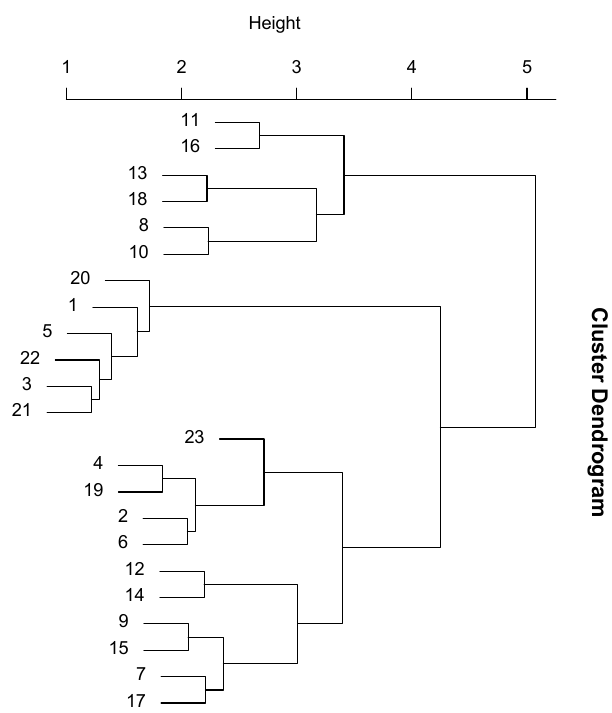
Figure 5. Article cue cluster dendrogram in the advanced proficiency group. Table 3. Usage-based categories of article cues in advanced proficiency group. Category Cue